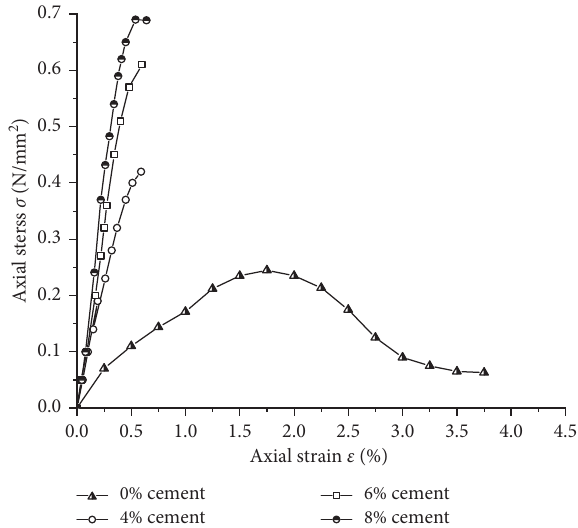
Figure 5: Correlation of stress and strain: cement treated soil at various fractions.